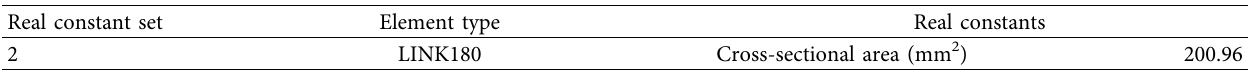
Table 4: Element type and real constants used for FEM of steel